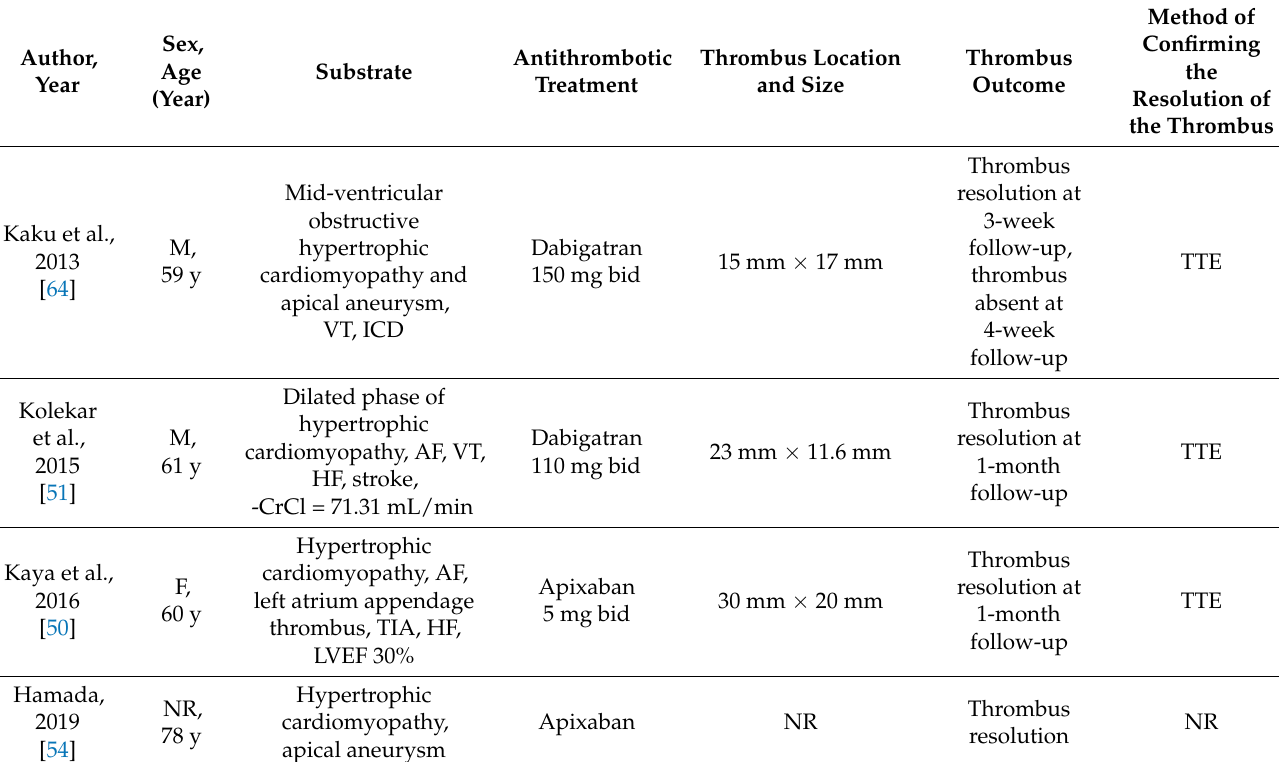
Table 2. LV thrombus in patients with hypertrophic